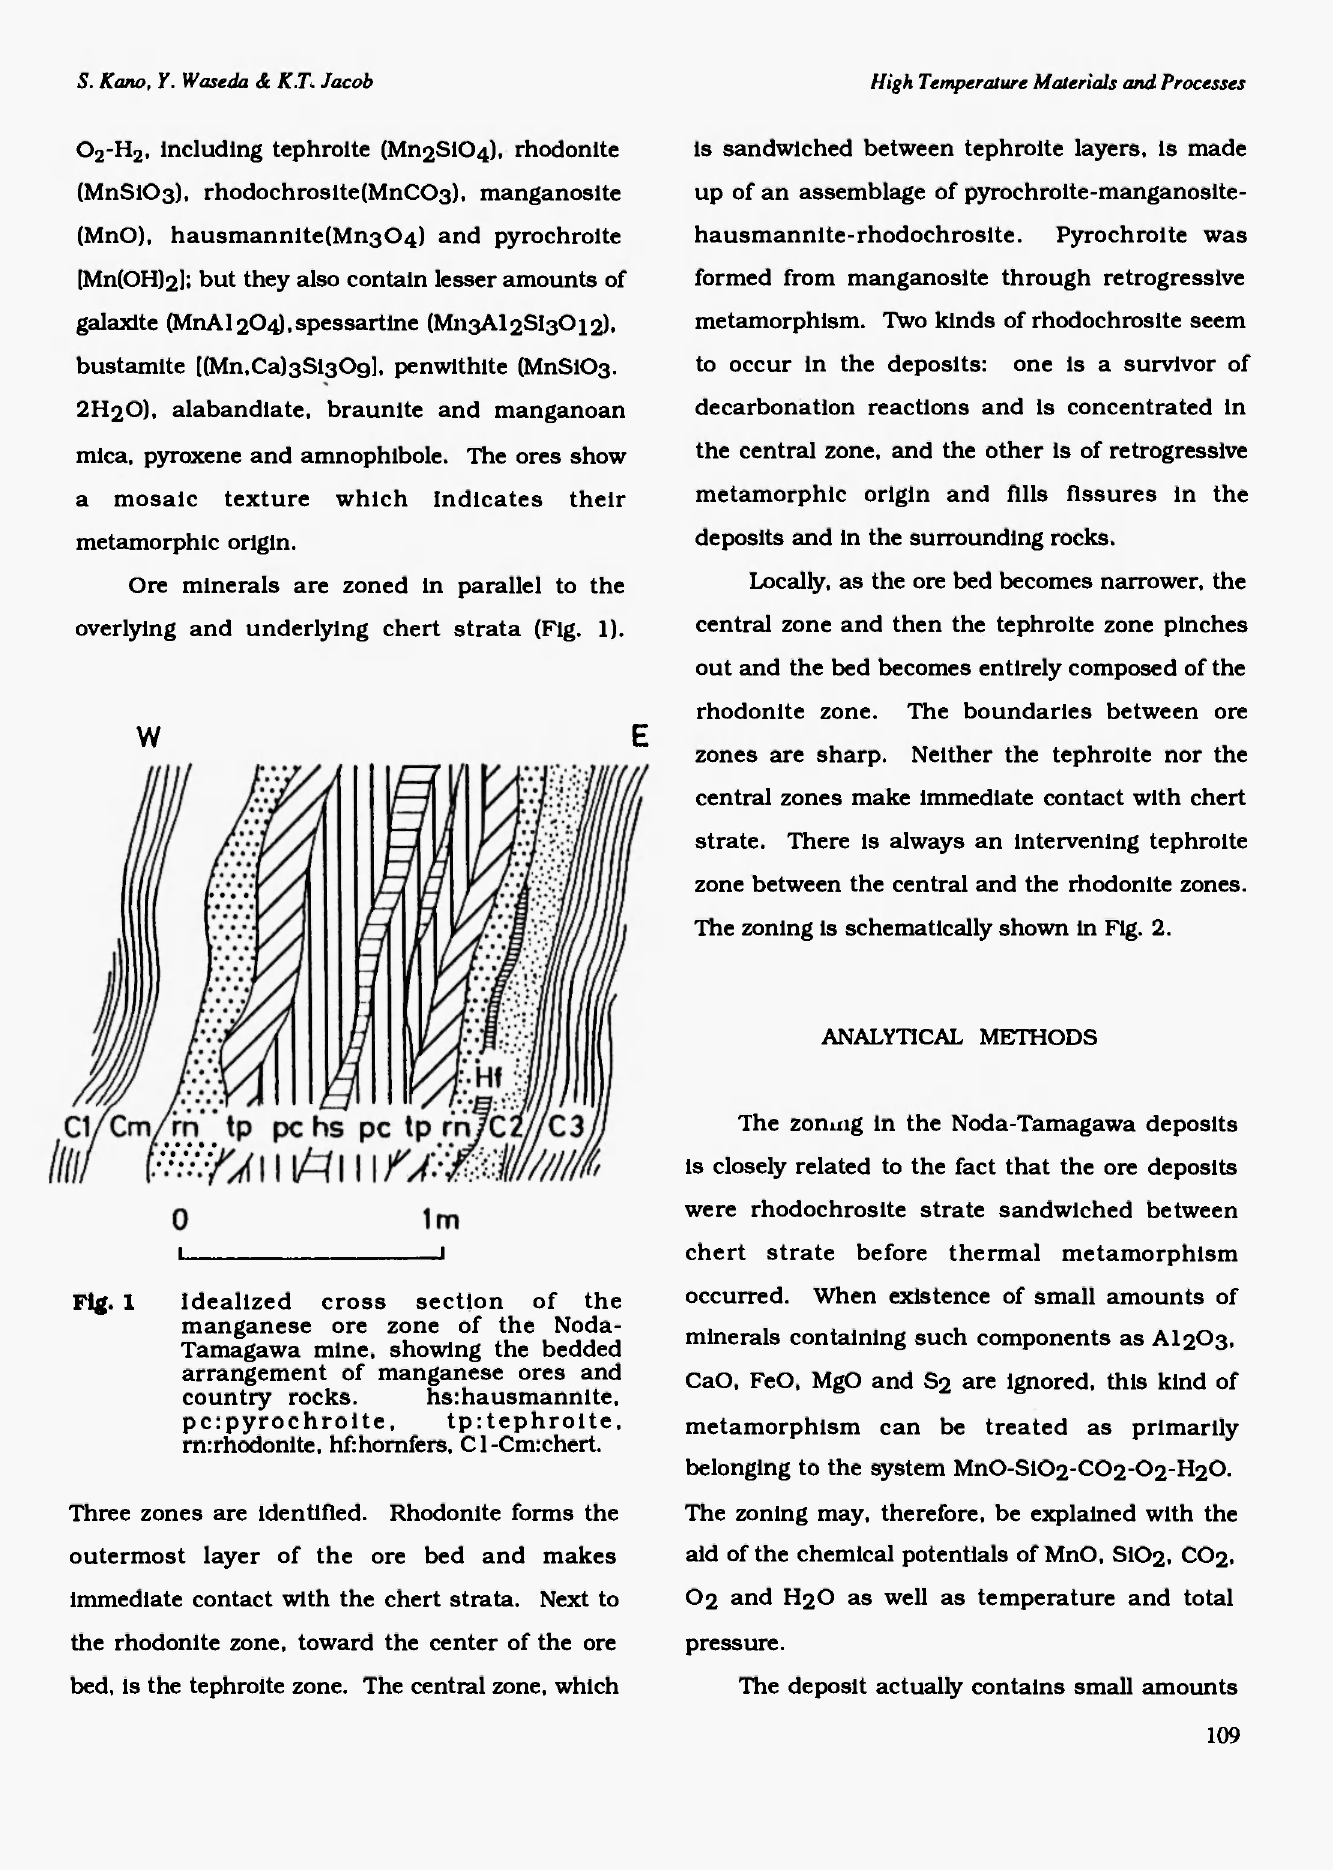
Fig. 1 Idealized cross section of the manganese ore zone of the Noda- Tamagawa mine, showing the bedded arrangement of manganese ores and country rocks. hs:hausmannite, p c : p y r o c h r o i t e, tprtephroite, rnrrhodonite, hf:hornfers,